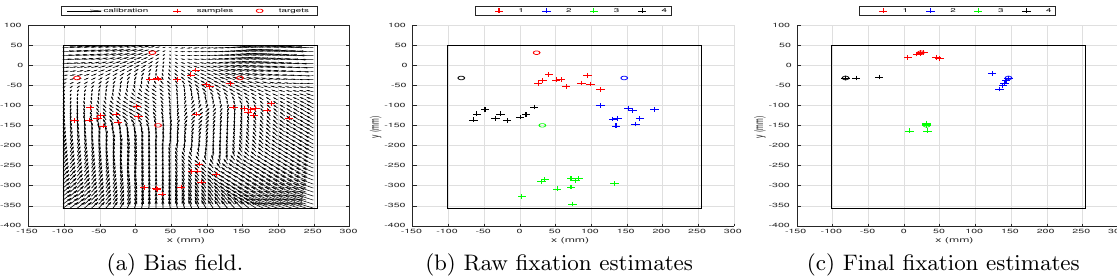
Figure 3: Fixation estimates at four example positions on the computer screen. (a) Bias field correction (computed only once) offsets raw fixation estimates compensating system inaccuracies. This provides an example of the importance of adjusting for challenges common in consumer scenarios. (b) Raw fixation estimates (+) and targets (o) colored by target. While precise estimations for important task is already obtained, this can be further improved. (c) Fixation estimates corrected with bias field; showing the high accuracy obtained with the RealSense low-cost RGBD camera. Sub-cm accuracy is obtained. Target